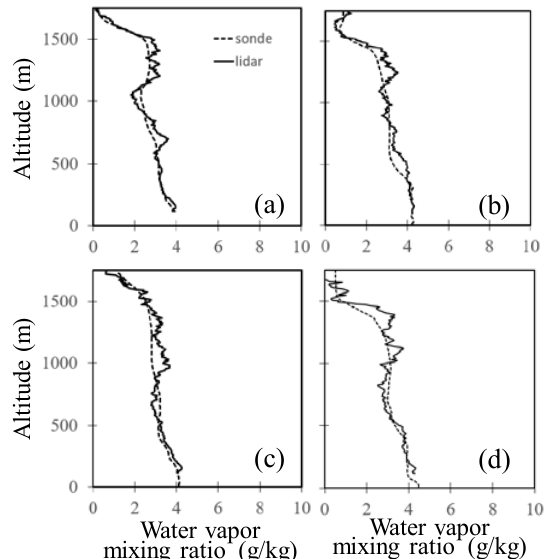
Figure 2. Water vapor mixing ratio profiles from the radiosonde (dashed line) and the Raman lidars (solid line) at Shigaraki, Japan at (a) 20:59–21:14 JST on December 22, 2017; (b) 01:15–01:30 JST; (c) 07:21–07:36 JST and (d) 10:41–10:56 JST on December 23, 2017. The range resolution of the Raman lidar changes in height from 30 m to 150 m, considering the Raman signal